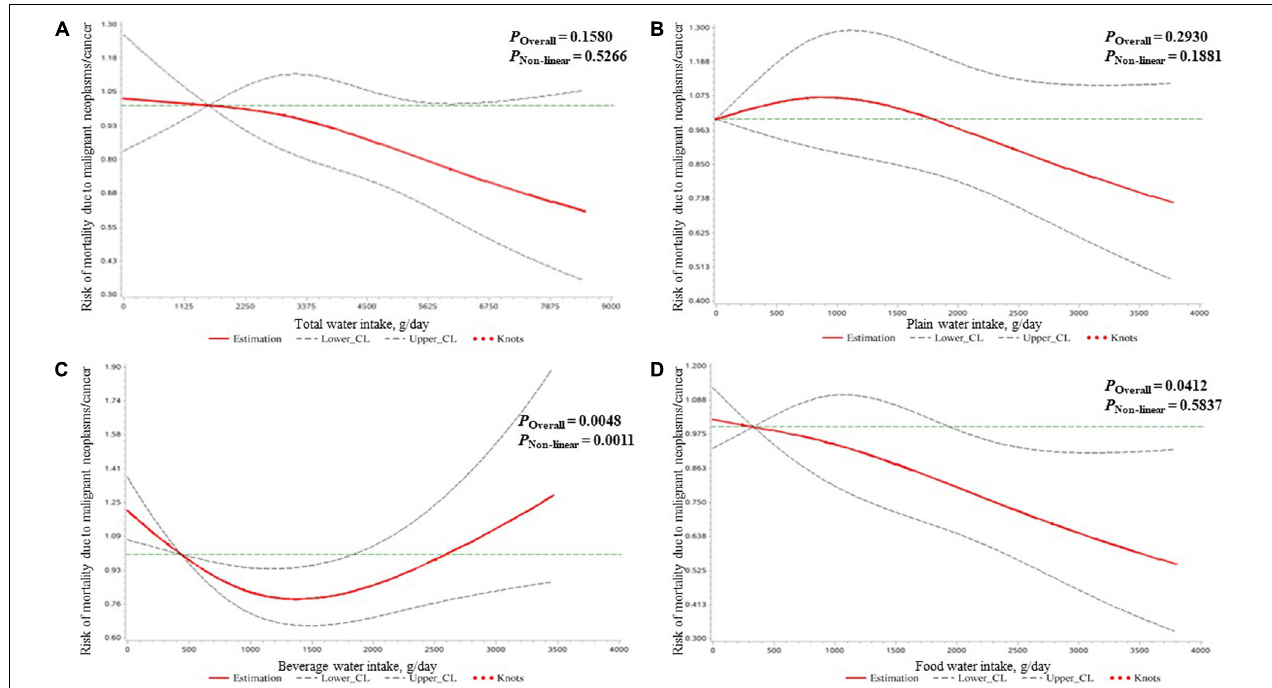
FIGURE 2 | The dose–response relationships of the amount of water intake [expressed by total water (A) , plain water (B) , beverage water (C) , and food water (D) ] with the mortality risk due to malignant neoplasms/cancer in all participants clarified by restricted cubic spline plots.